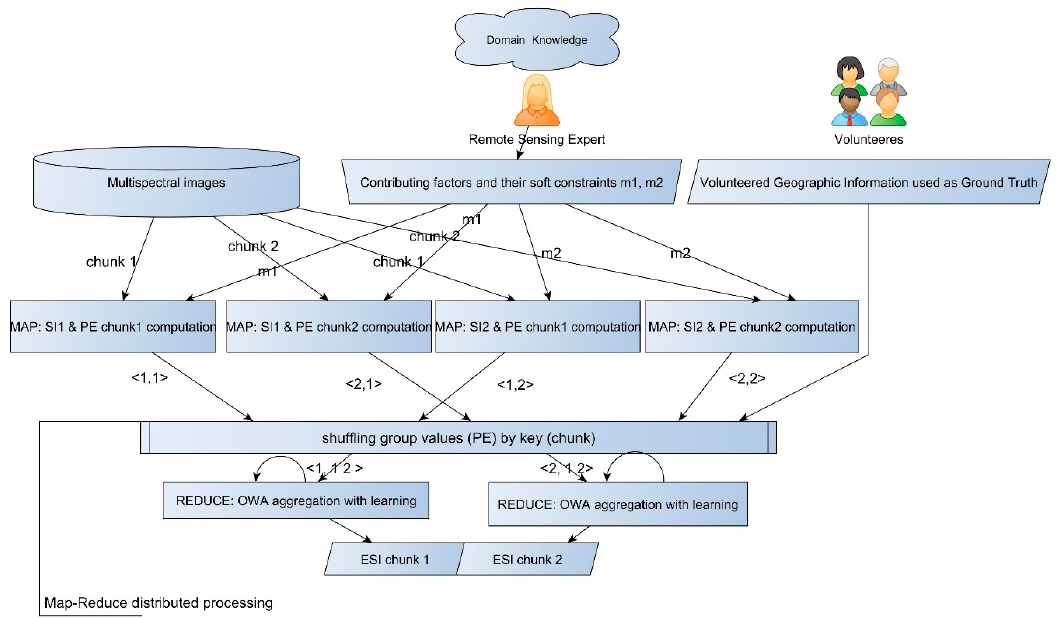
Figure 4. Map-reduce distributed process computation of the ESI map.